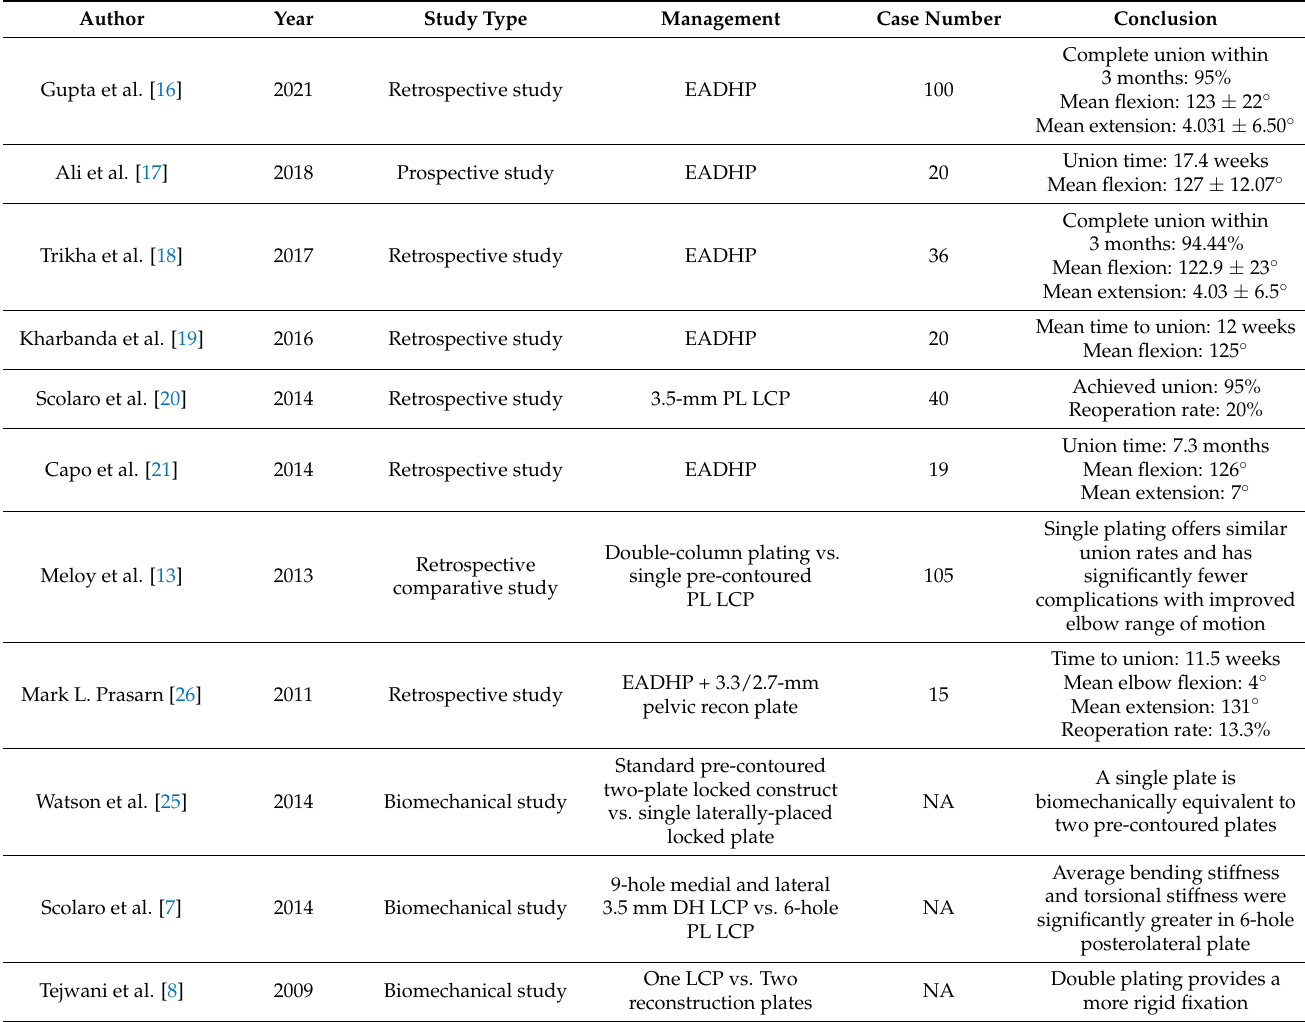
Table 4. Summary of the literature review of distal-third humeral